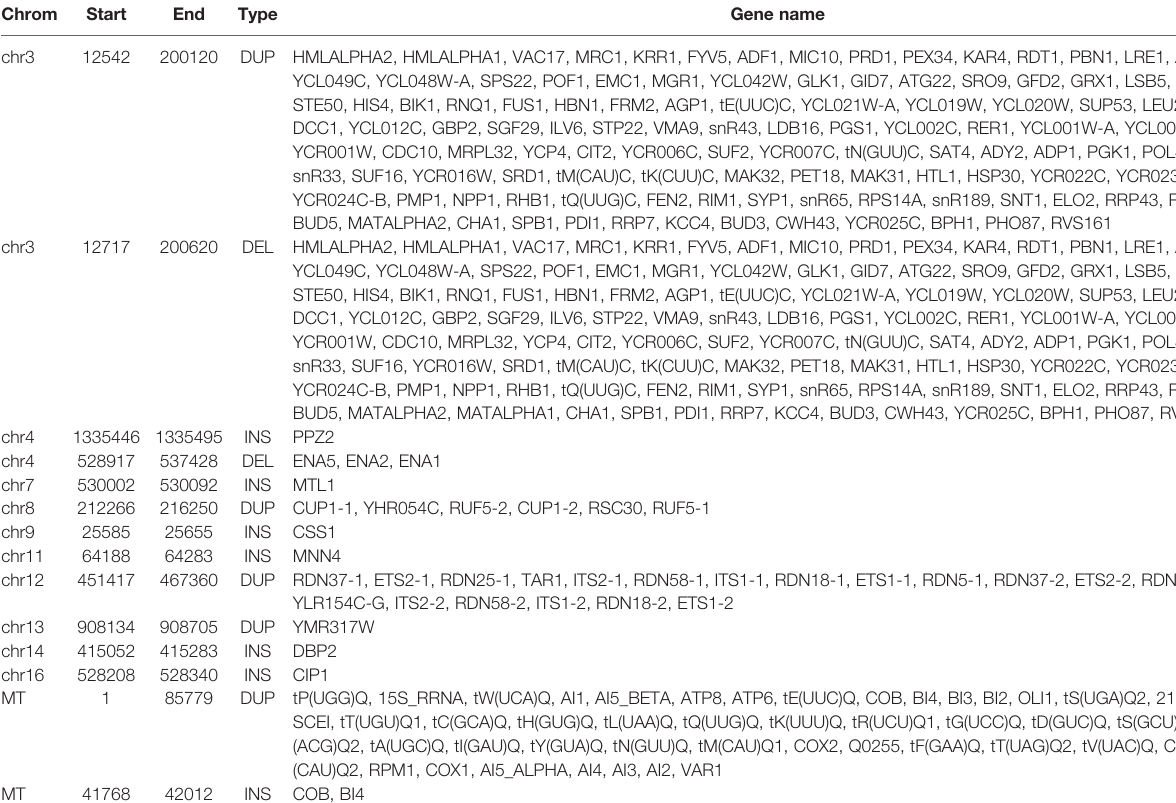
TABLE 3 | The common SVs in both BY4742 and